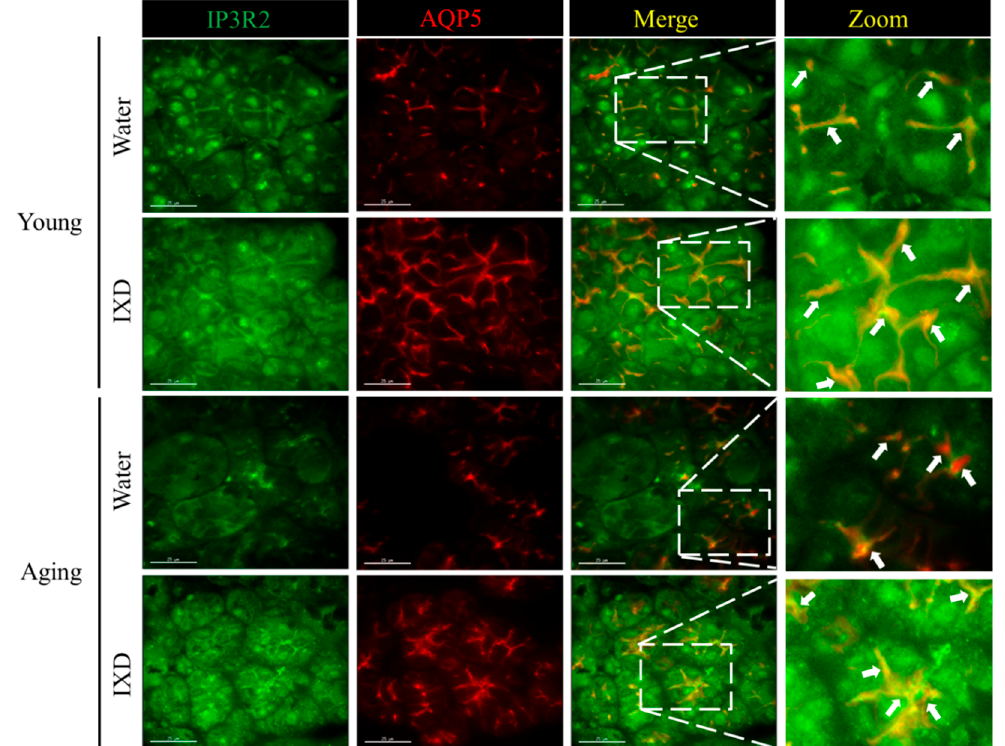
Figure 5. Expression of IP3R2 and Aquaporin-5 (AQP5) in submandibular glands from young and aging rats treated with water or IXD extract (100 mg/kg) was observed by confocal microscopy. Left panel shows the IP3R2 expression in young and aging rats treated as mentioned in the figure. Second panel show the AQP5 staining within apical region of the acinar cells. Third panel show the overlay of IP3R2 and AQP5. Right panel show the zoomed picture of the co-localized IP3R2 and AQP5. White arrows indicate the overlay of IP3R2 and AQP5 within apical regions of submandibular gland acinar cells. The young group shows a uniform and clear co-localization of IP3R2 and AQP5, aging control rats show less overlapping, and IXD treated aging rats show the increased expression and higher overlapping in the apical regions. Scale bar: 25 microns .